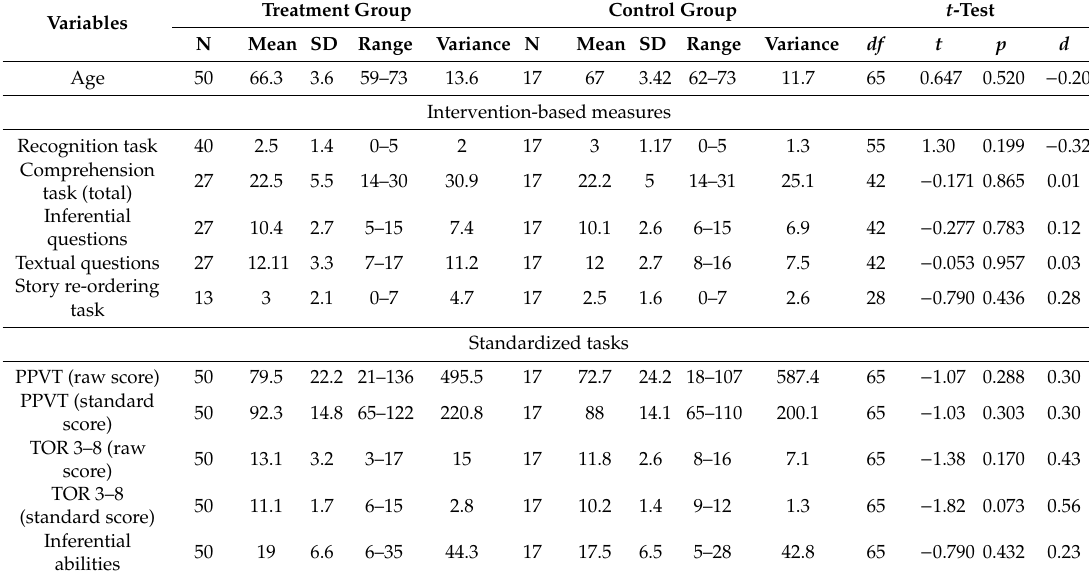
Table 1. Characteristics of participants and group comparison at Time